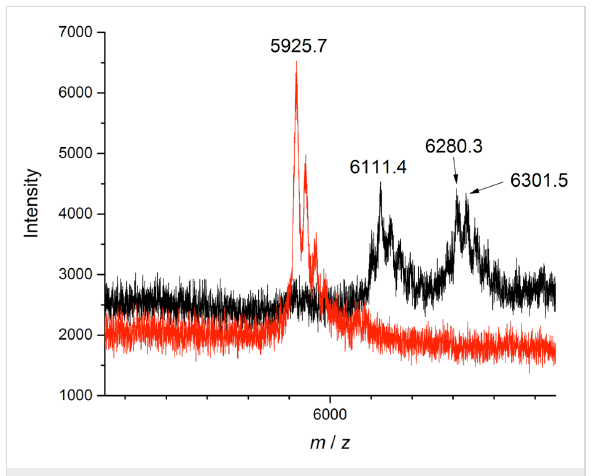
Figure 3: MALDI–TOF mass spectra (black: 17 , red: FhuA Δ CVF tev ).